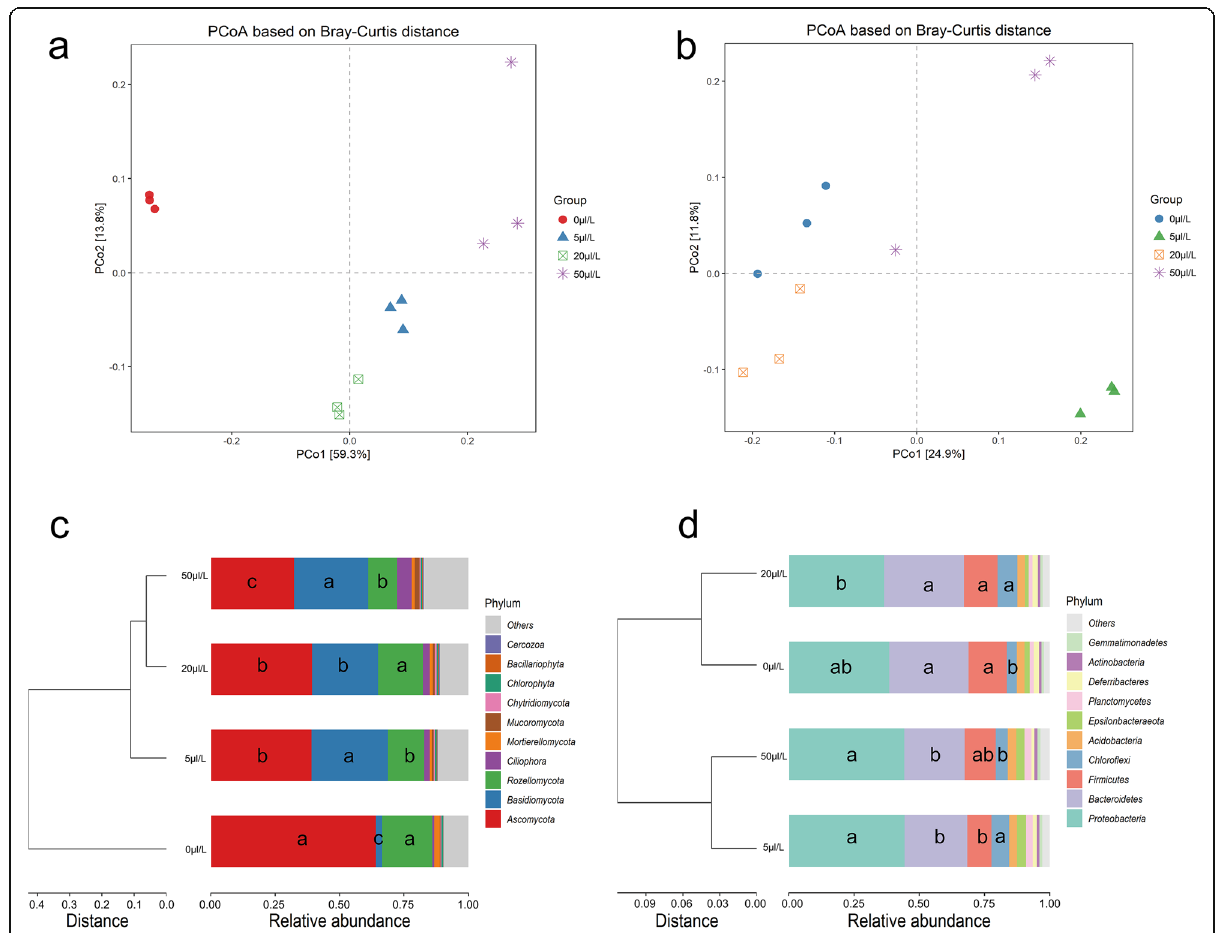
Fig. 4 Principal coordinates analysis (PCoA), clustering and the relative abundances of fungi and bacteria at the phylum level after 4 weeks of fumigation with different concentrations of α -terpineol. a and b The PCoAs of fungal and bacterial communities, respectively. c and d The clustering and relative abundances of fungal and bacterial communities at the phylum level, respectively. Different letters indicate significant differences analyzed by one-way ANOVA with Duncan ’ s multiple range test, P <